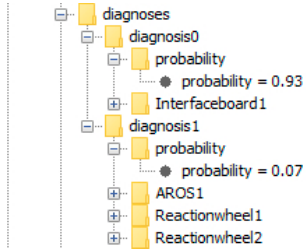
Figure 30. The two diagnoses listed in the diagnosis.xml-file. The first diagnosis only contains Interfaceboard1 and has a probability of 0.93 and the second diagnosis consists of AROS1, Reactionwheel1, as well as Reactionwheel2 and it has a probability of 0.07.